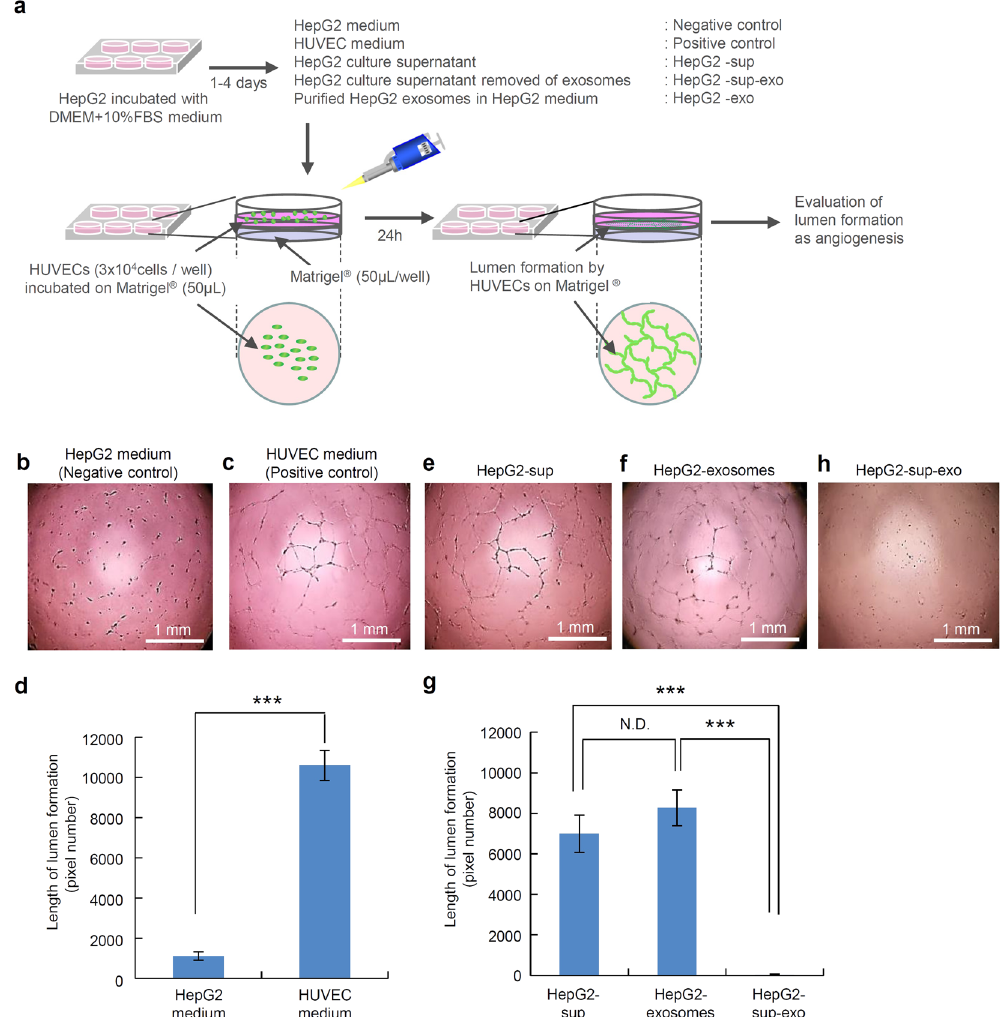
Figure 2. The lumen formation by HUVECs treated with HepG2-exosomes. ( a ) The schematic diagram of the experimental protocol is shown. The upper diagram shows the preparation of the culture medium and supplements, such as the HepG2 medium (negative control), HUVEC medium (positive control), HepG2 culture supernatant (HepG2-sup), purified HepG2 exosomes (HepG2-exosomes) and HepG2 culture supernatant with the exosomes removed (HepG2-sup-exo). The lower diagram shows the preparation used to assess the lumen formation of HUVECs in plates coated with growth factor-reduced Matrigel. The lumen formation of HUVECs on Matrigel was observed using a phase-contrast microscope. ( b,c,e,f,h ) The lumen formation by HUVECs under various culture conditions, such as HepG2 medium (negative control), HUVEC medium (positive control), HepG2 culture supernatant (HepG2-sup), purified HepG2 exosomes (HepG2- exosomes) added to HepG2 medium and HepG2 culture supernatant with the exosomes removed (HepG2- sup-exo). ( d ) The comparison of the length of the lumens formed by HUVECs between the HepG2 medium (negative control) and HUVEC medium (positive control). ( g ) The comparison of the length of the lumens formed by HUVECs between HepG2 culture supernatant (HepG2-sup), purified HepG2 exosomes (HepG2- exosomes) and HepG2 culture supernatant with the exosomes removed (HepG2-sup-exo). These data are shown as the means ± standard deviation of triplicate values. *** P <